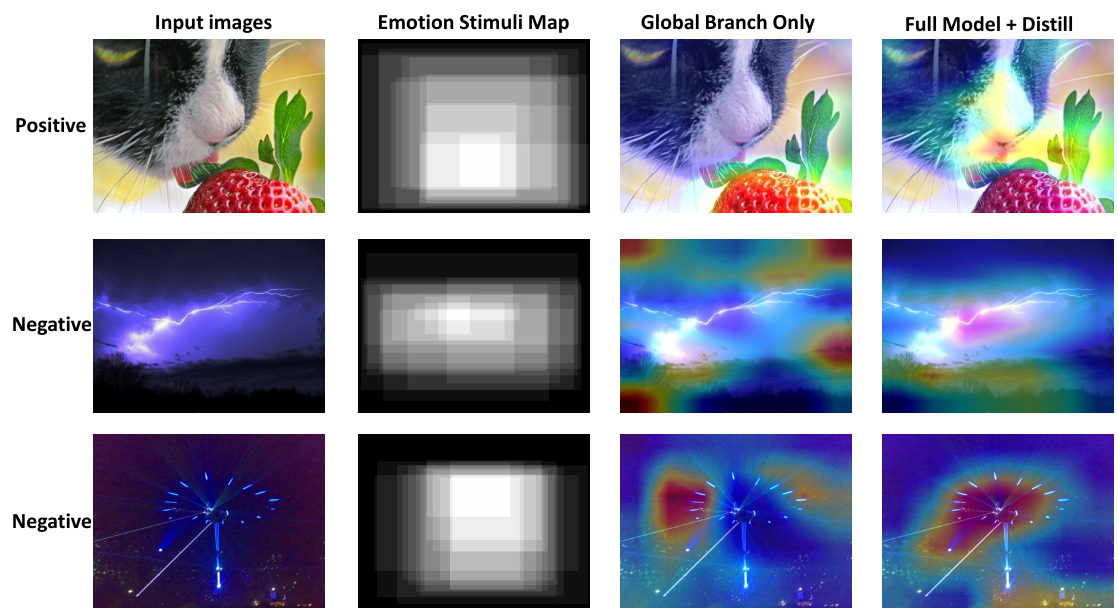
Figure 5. Qualitative results on 3 images from EmotionROI. For each image, the first column from the left is the original input image and the second column is the Emotion Stimuli Map annotated by person, while the third and forth columns are saliency maps from the two models: “Global Branch only” and “Full Model + Distill”. Specifically, blue color indicates low attention weights, while red means the